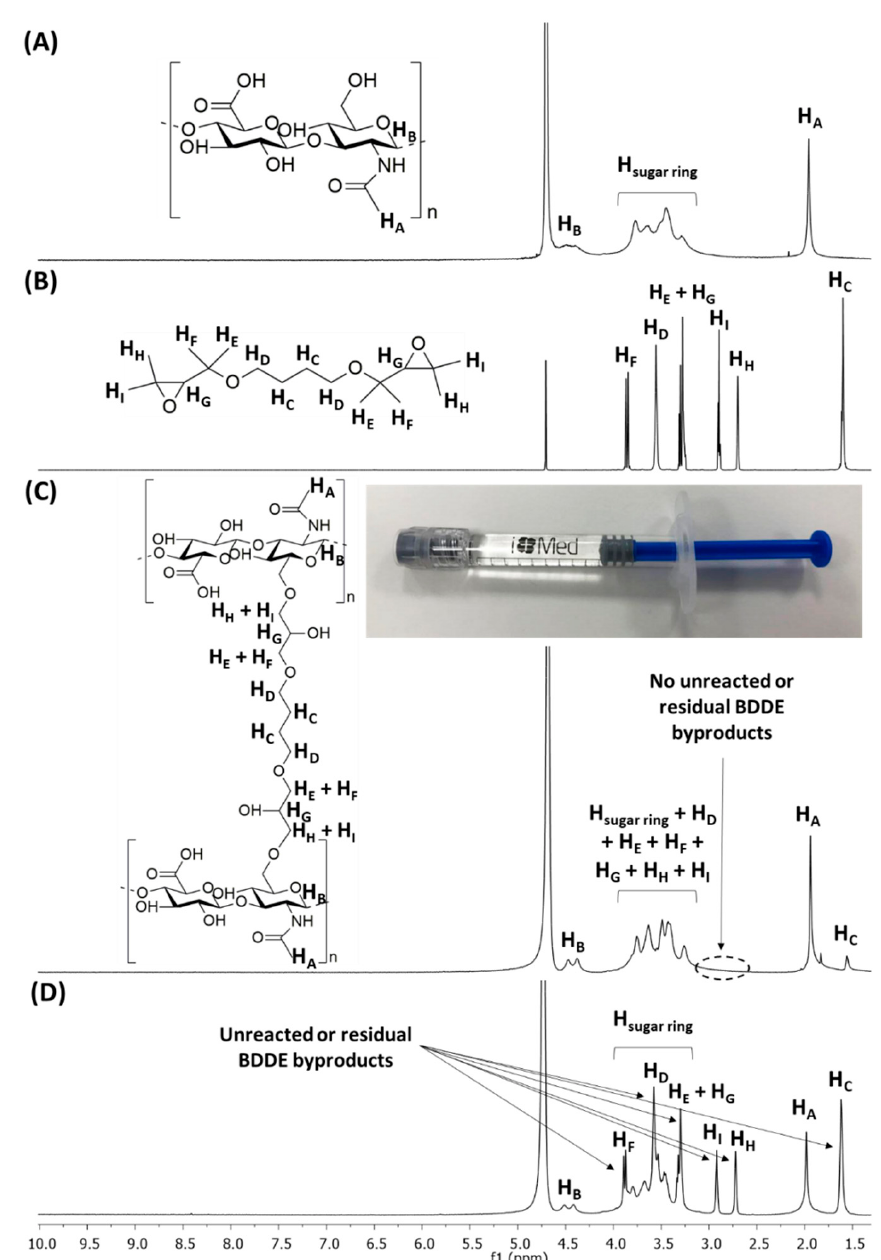
Figure 1. 1 H-NMR spectra of ( A ) HA and ( B ) BDDE and HA-BDDE gels ( C ) after and ( D ) before the dialysis process. Solvent: D 2 O (4.70 ppm).